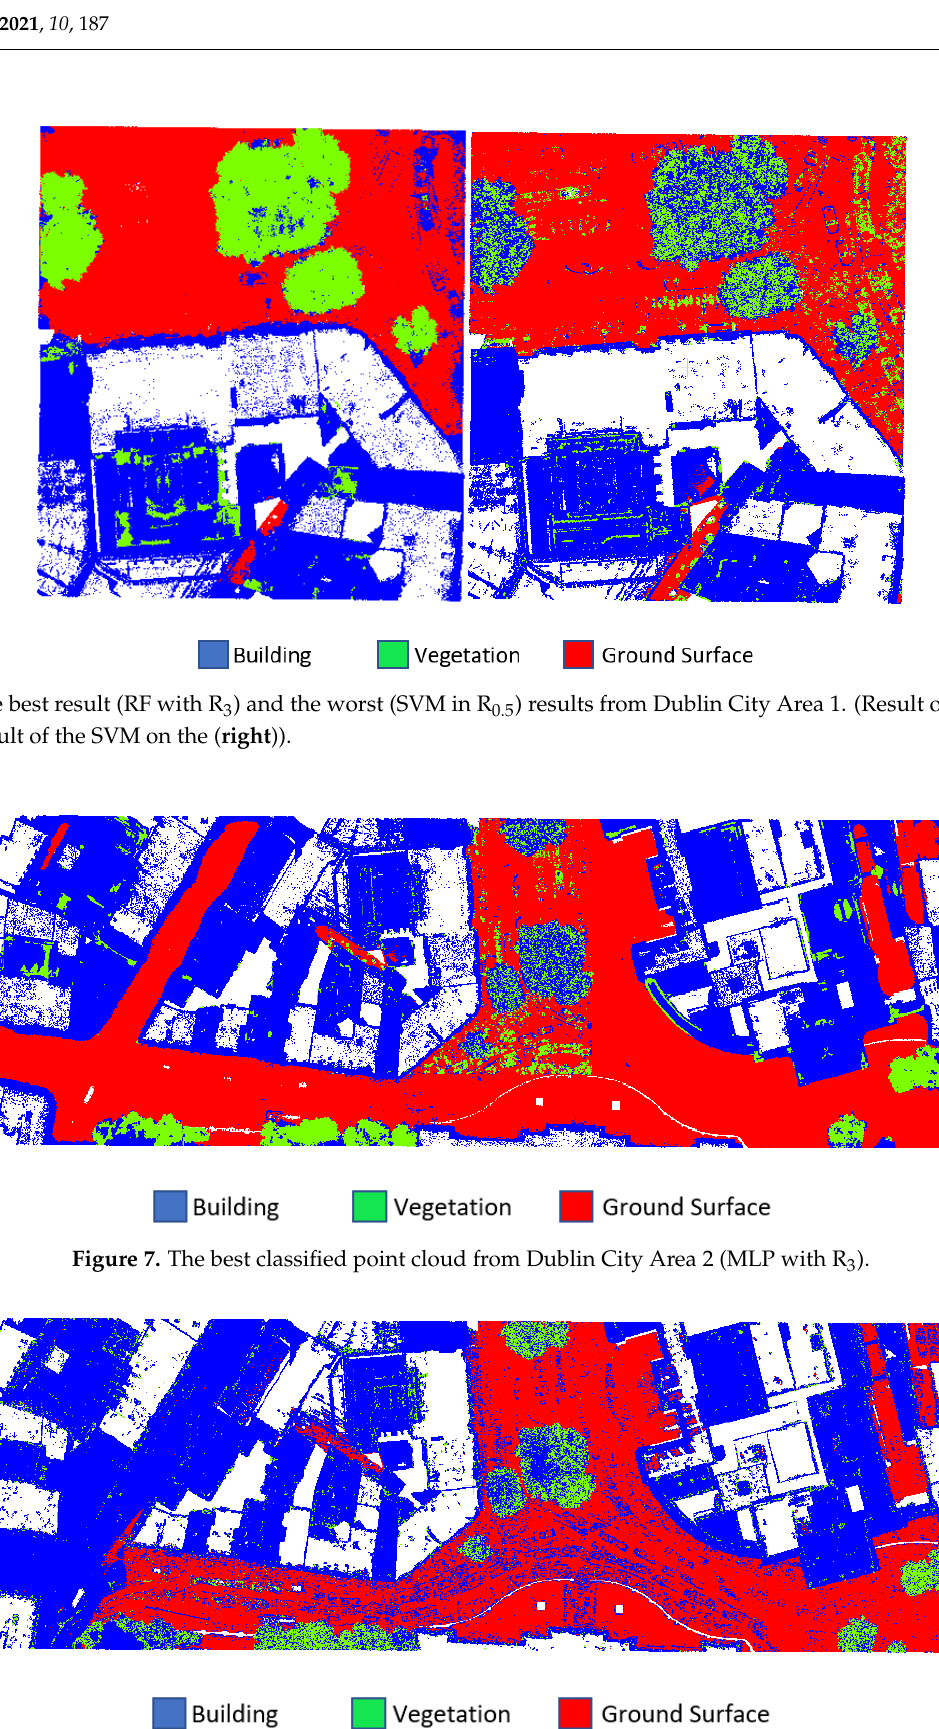
Figure 8. The worst classified point cloud from Dublin City Area 2 (DT with R 0.5 ).